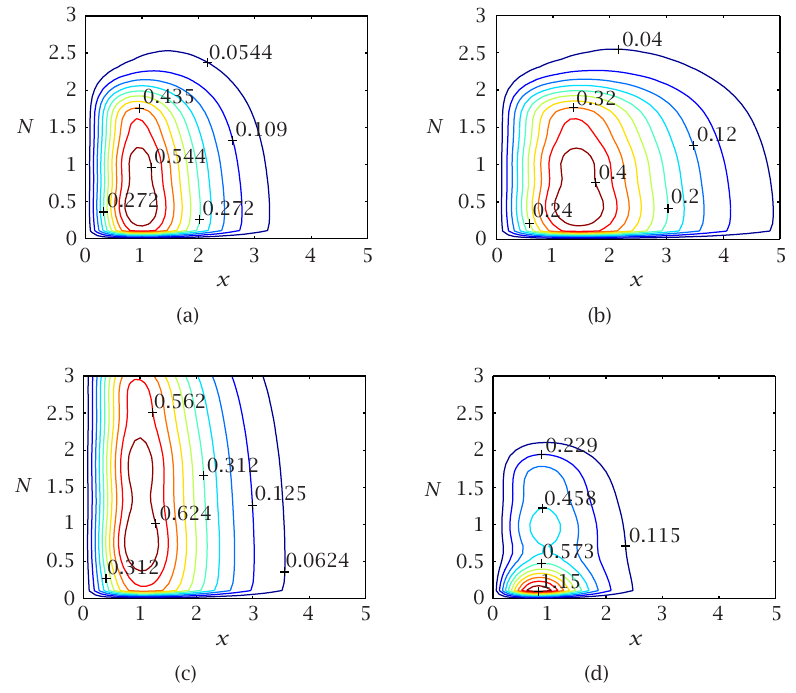
Figure 6.6 . The contours of the concentration of dust for the ver- tical source at a fixed time, t = 5 . 0, for different sets of the param- eters: (a) ν = 0 . 5, b = 0 . 5, L = 1 . 0, (b) ν = 0 . 5, b = 1 . 5, L = 1 . 0, (c) ν = 0 . 5, b = 0 . 5, L = 3 . 0, and (d) ν = 2 . 0, b = 0 . 5, L = 1 .